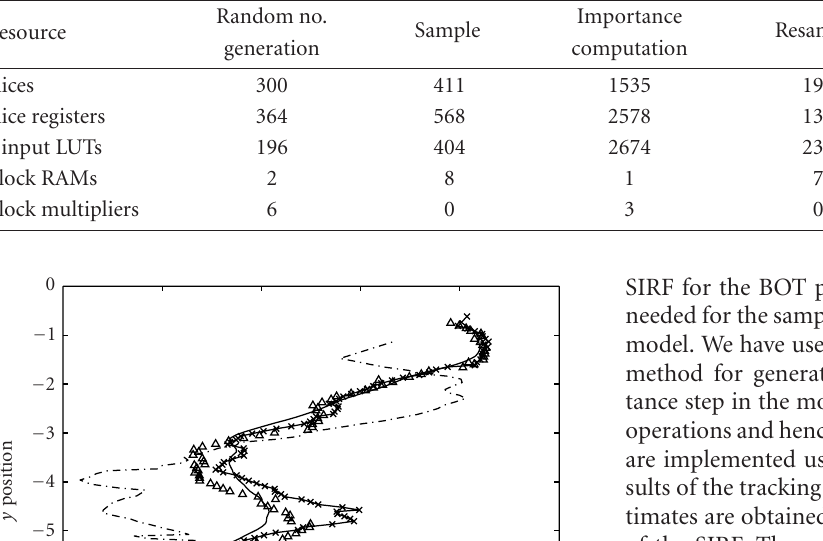
Table 5: Resource utilization for entire SIRF for the bearings-only tracking problem using scheme 1.